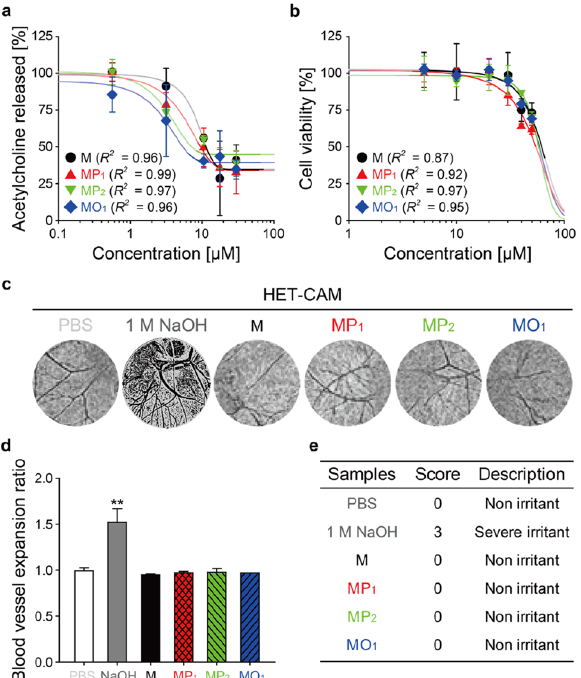
Figure 5. Comparison of inhibitory activity of acyl myricetins on neurotransmitter release and their safety evaluation. ( a ) Inhibition of acetylcholine release from differentiated PC-12 cells by M, MP 1 , MP 2 and MO 1 . ( b ) Cytotoxicity of acyl myricetins on PC-12 cells, determined by neutral red uptake assay. ( c ) Images of the HET- CAM test after treatment with 2 mL of PBS, 1 M NaOH aqueous solution, and 1 mg·mL −1 solutions of M, MP 1 , MP 2 and MO 1 mixtures, which were evaluated using ImageJ to determine the area of blood vessels. ( d ) Ratios of the black pixel area fraction (%Area) in the ImageJ images between after and before the sample solution treatments (blood vessel expansion ratio). Student’s t -test: **, p < 0.01. ( e ) Scores obtained from the HET-CAM test results. Data are expressed as the mean ± s.d ( a , b , d